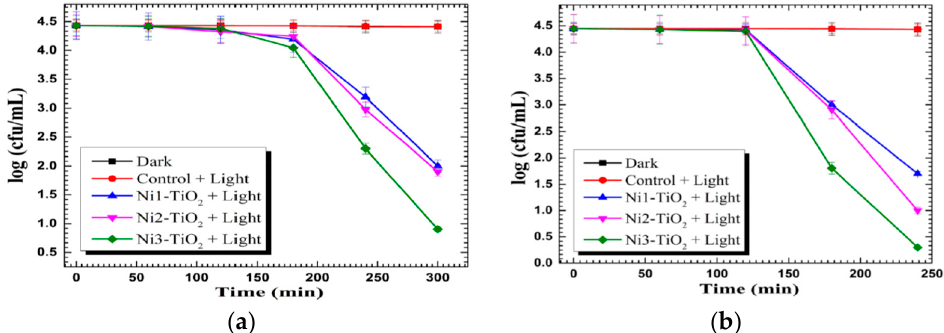
Figure 16. Inactivation of ( a ) E. coli and ( b ) S. aureus by Ni-doped TiO 2 NPs as a function of time. Reproduced with permission from [248]. Copyright Elsevier, 2014.